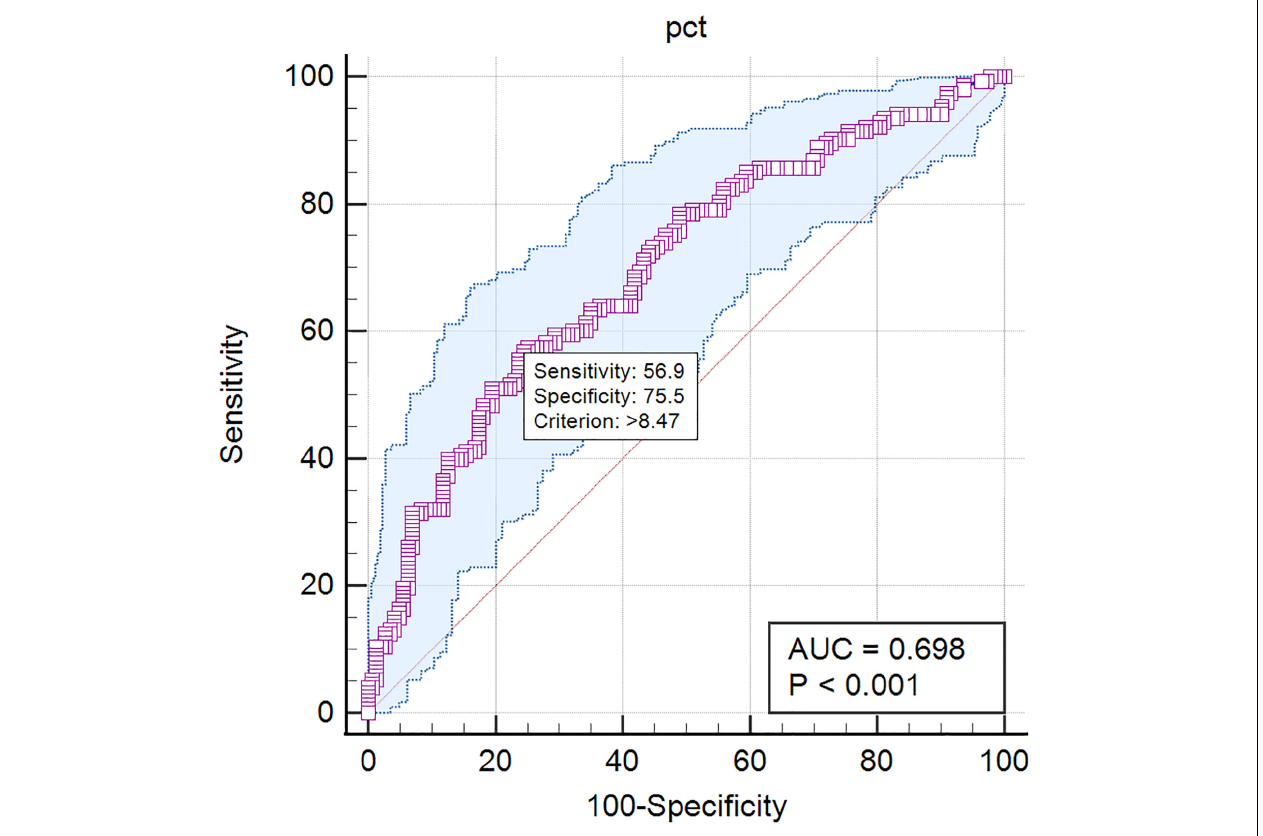
FIGURE 2 | The ROC curves of PCT predicting Gram-negative bacteremia from Gram-positive bacteremia. PCT: AUC = 0.698, cutoff point 8.47 ng/mL, sensitivity 56.9%, specificity 75.5%.